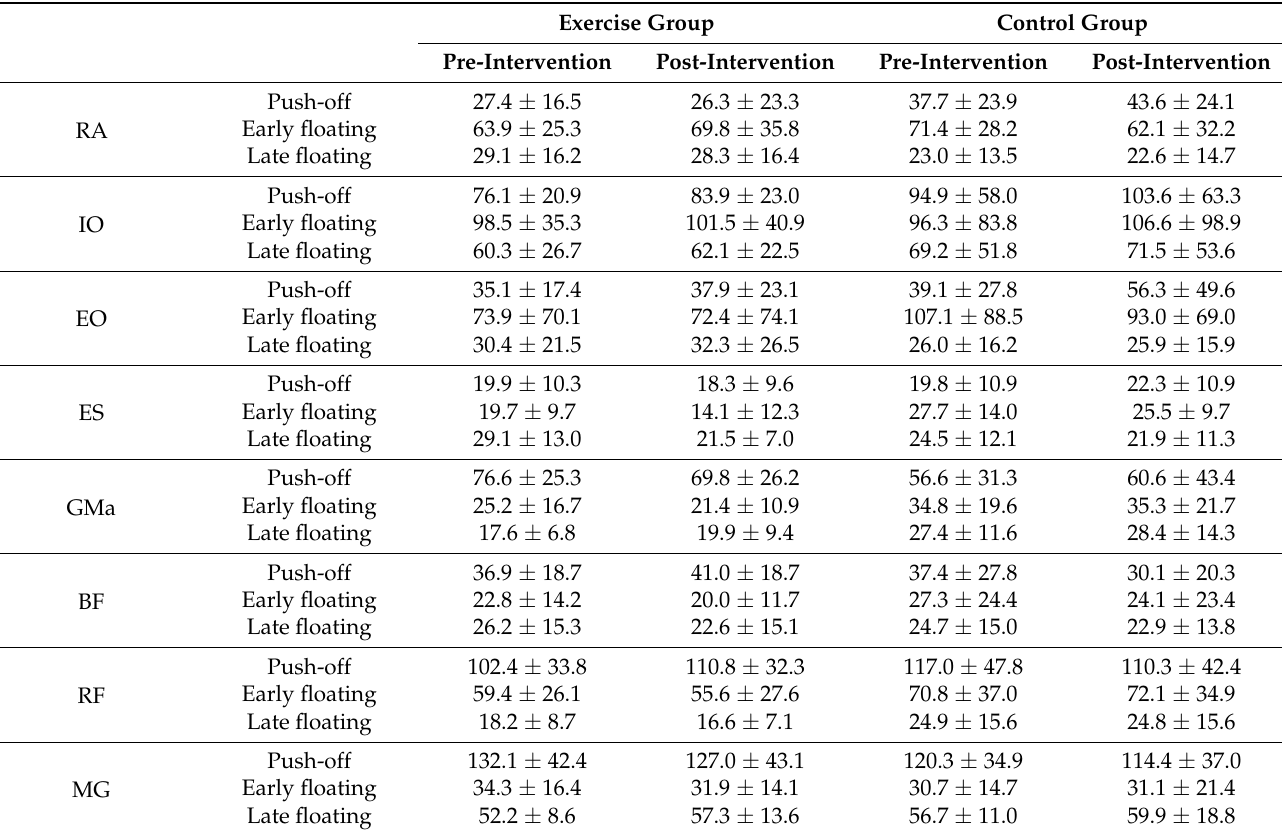
Table 2. Muscle activity in each group before and after intervention.